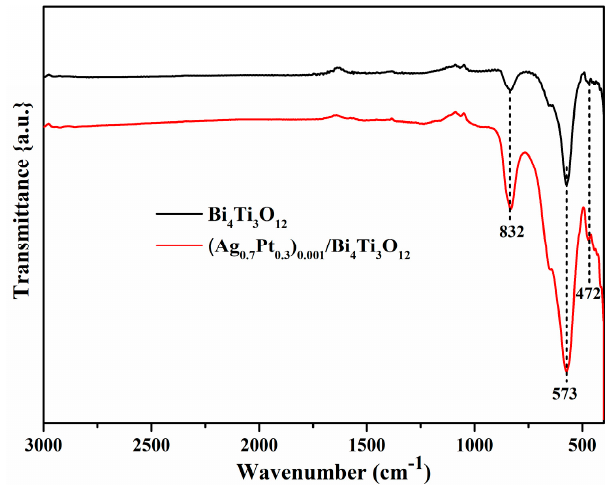
Figure 8. Fourier transform infrared (FTIR) spectra of Bi 4 Ti 3 O 12 and (Ag 0.7 Pt 0.3 ) 0.001 /Bi 4 Ti 3 O 12 .